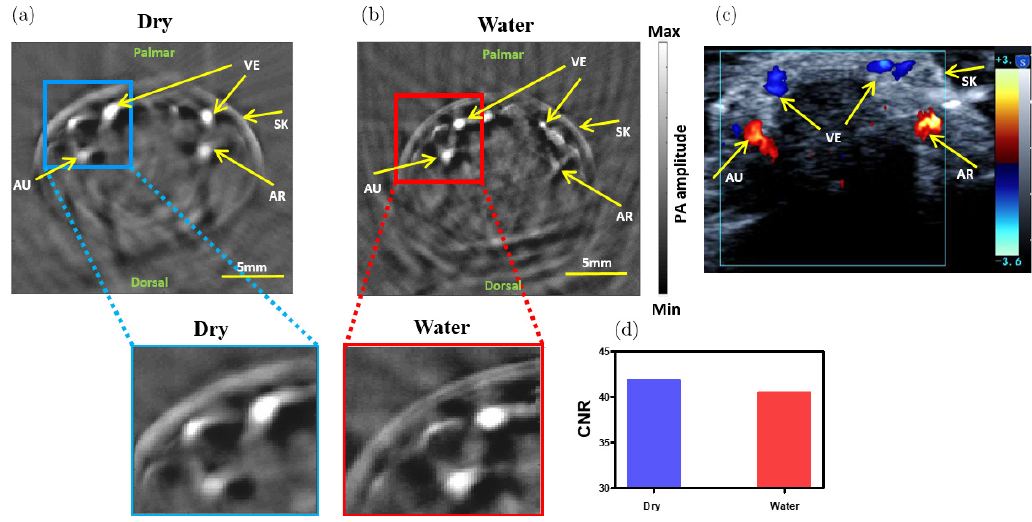
Fig. 4. Representative PAT Images of the PIP joint for a volunteer using dry coupling (a) and water coupling (b). (c) Corre- sponding duplex US indicates the veins of ¯nger joint. (d) CNR calculated from (a) and (b). PIP: proximal interphalangeal joint, AU: ulnar artery, AR: radial artery, VE: veins, SK: skin.